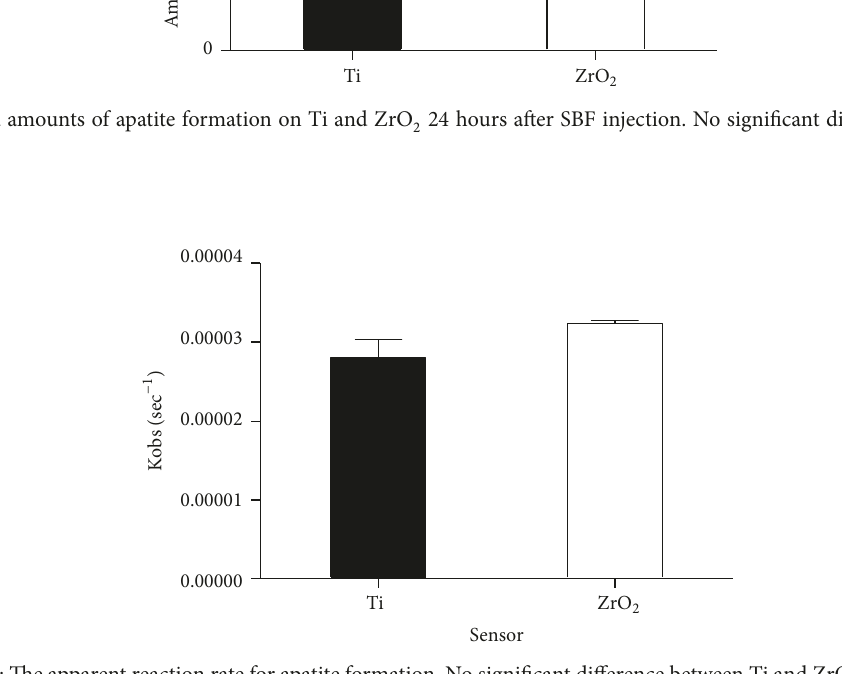
Figure 4: The apparent reaction rate for apatite formation. No significant difference between Ti and ZrO 2 ( 𝑝 > 0.05